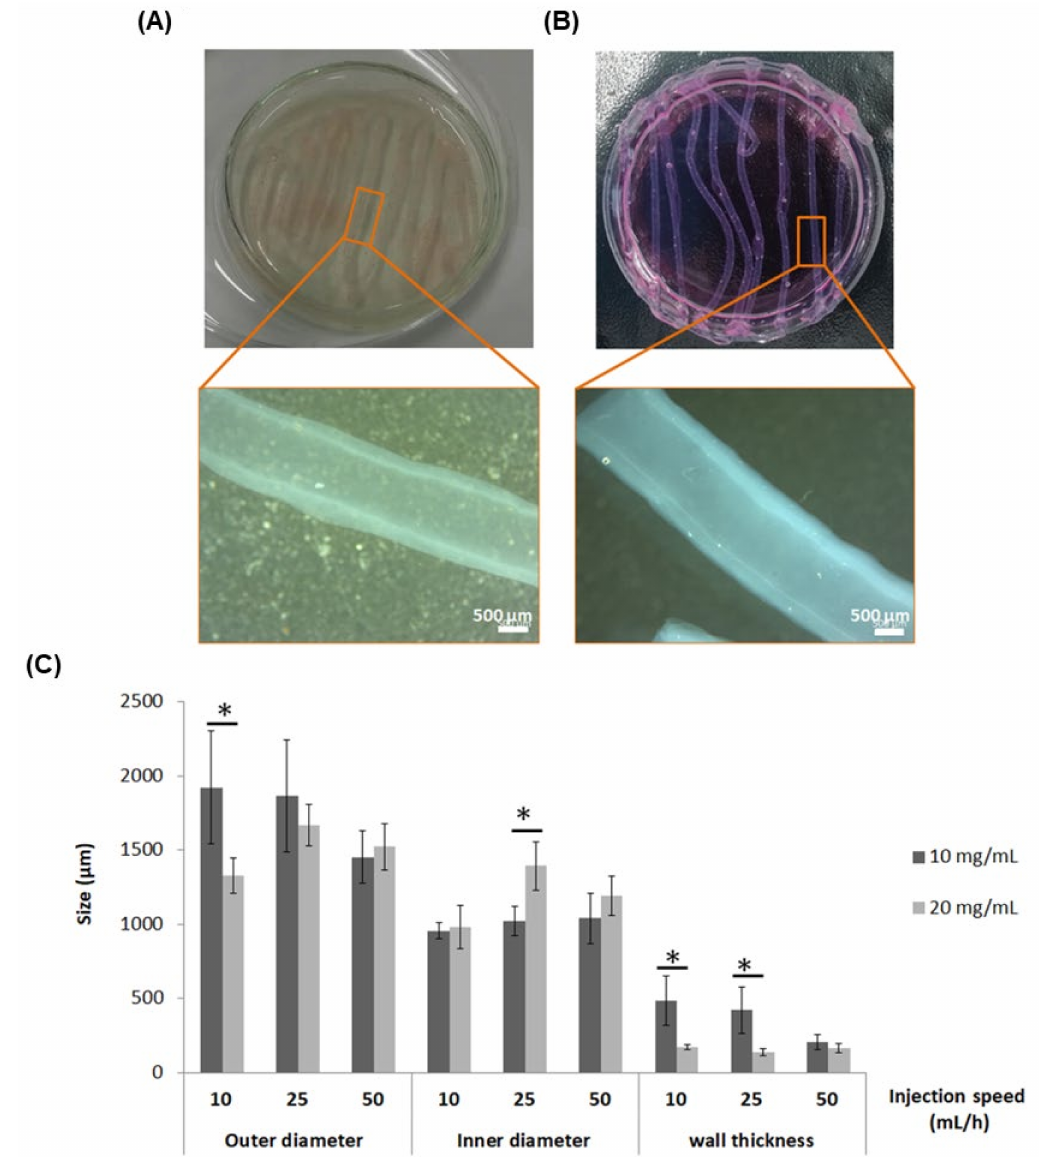
Figure 1. Tissue-engineered blood vessel (TEBV) support bath extrusion optimization and TEBV sizes. TEBVs extruded with collagen concentration of 10 mg/mL in ( A ) gelatin microparticles or ( B ) in cell culture media, with 25 mL/h as the injection speed. ( C ) Size of outer diameter, inner diameter and wall thickness depending on the injection speed with collagen at 10 mg/mL and 20 mg/mL. Data represented as mean with standard deviation ( n = 8 per condition). * Statistically significant differences between the two collagen concentrations for the same injection speed ( p <